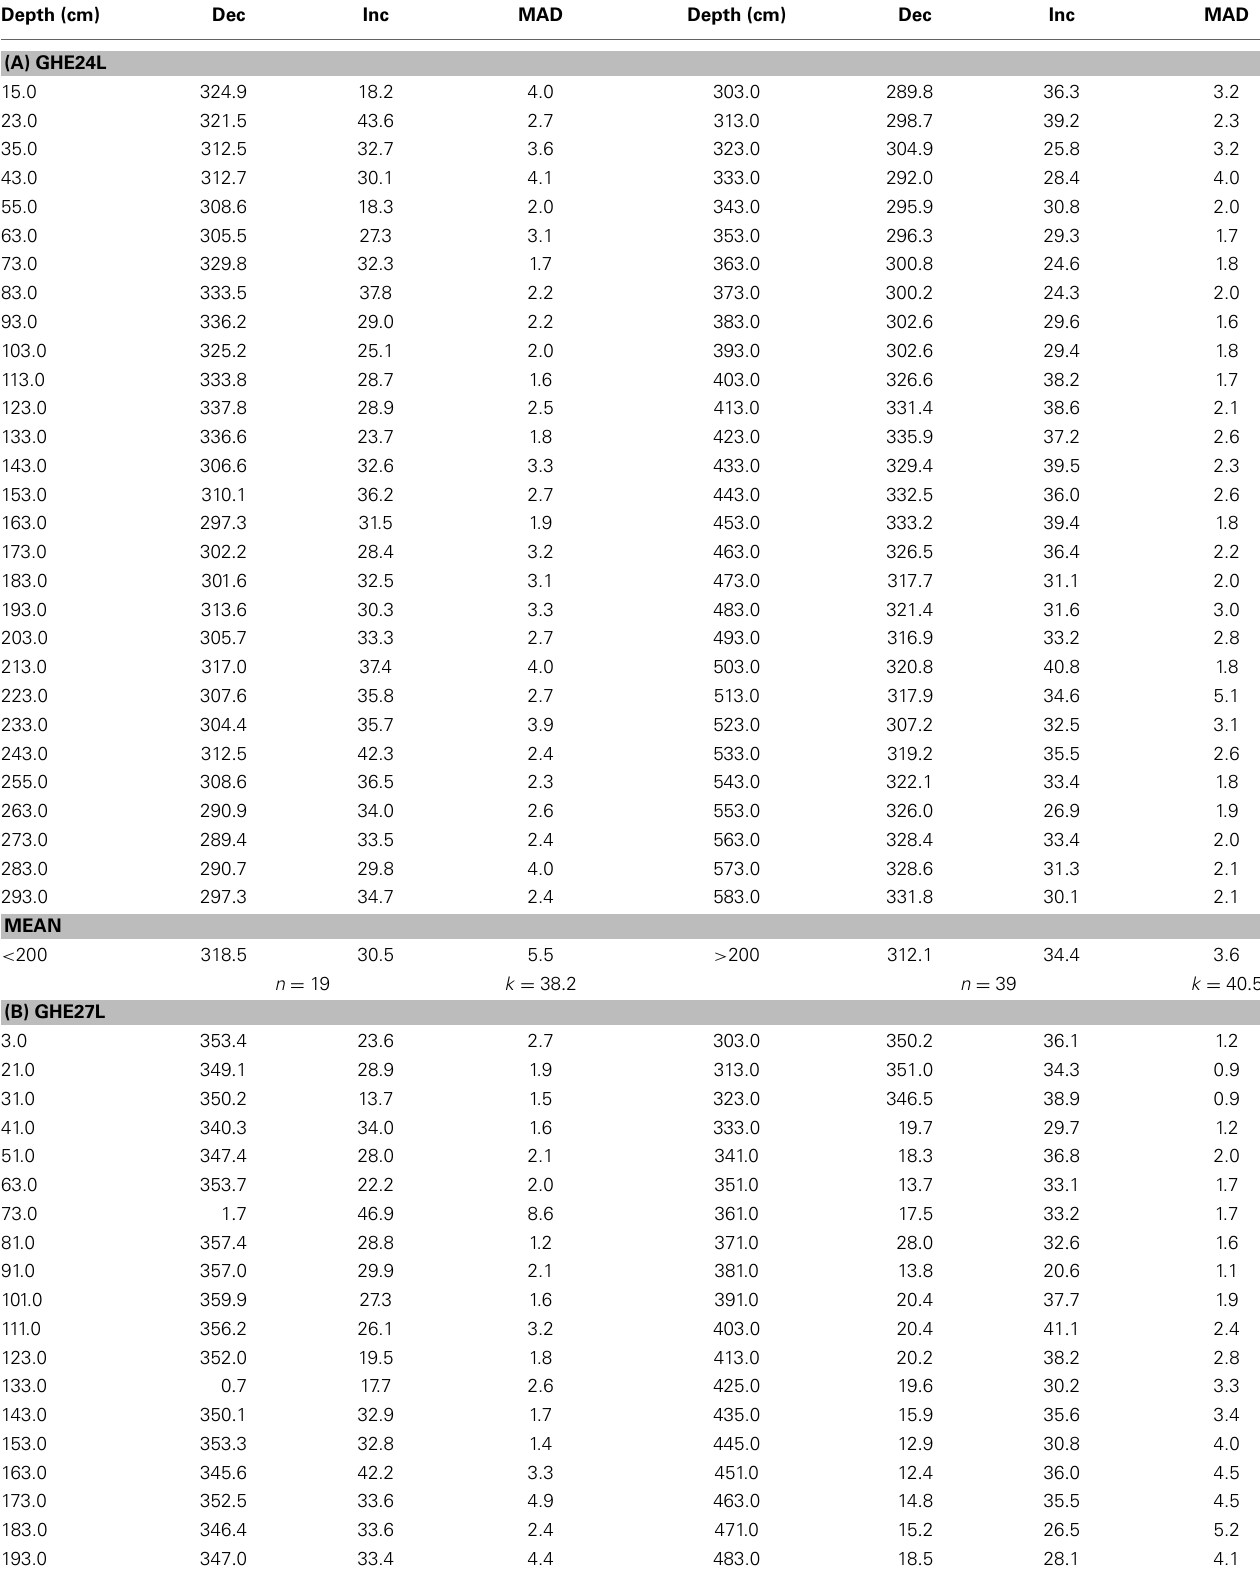
Table 2 | Paleomagnetic results from Cores GHE24L and